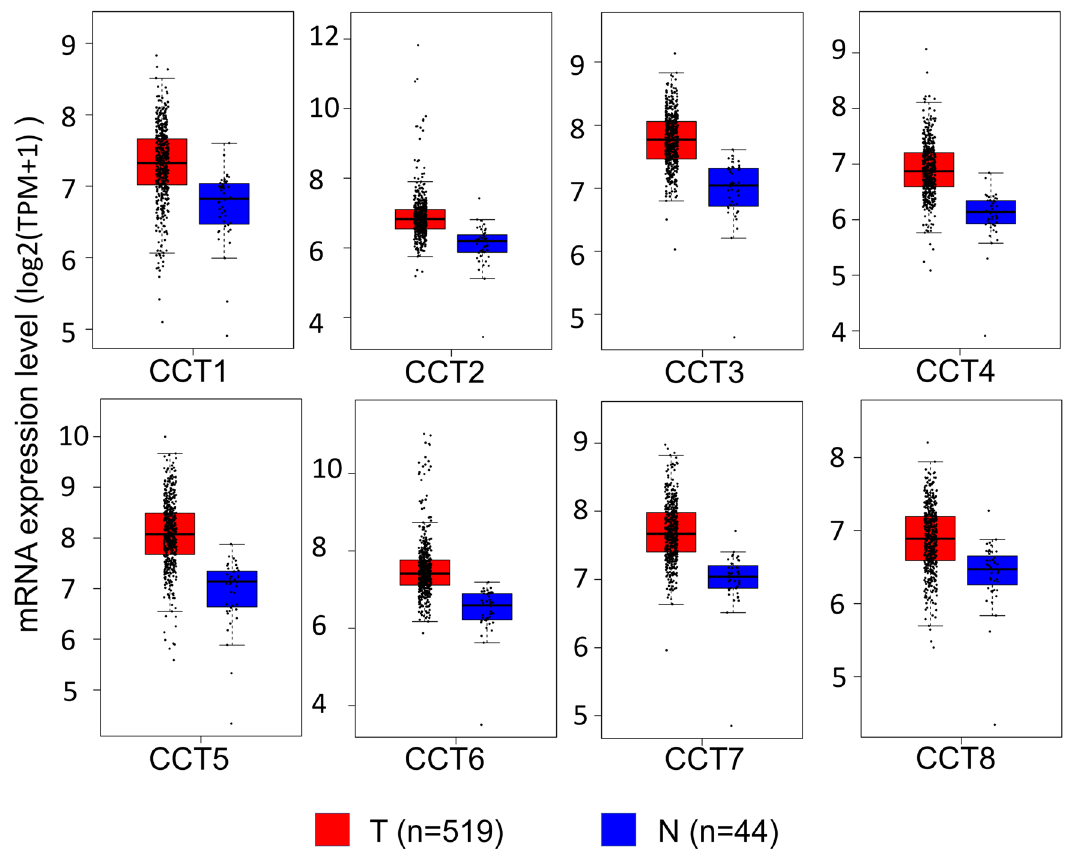
Figure 2: The expression level of CCTs in HNSC ( GEPIA ) . Boxplots showing the relative expression of eight CCTs in HNSC and normal samples. The red and blue boxes represent cancer and normal tissues,